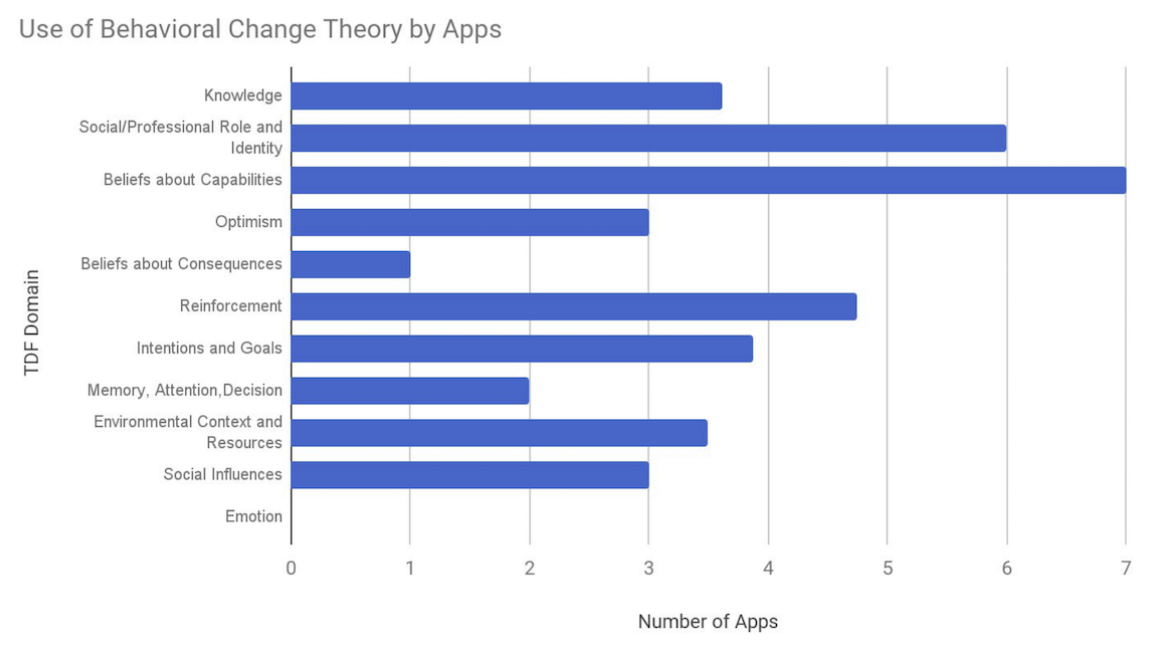
Figure 2. Number of apps that contain specific TDF domain features (for domains with multiple feature checklist questions, the average number of apps across the questions in the domain is reported). TDF: Theoretical Domains